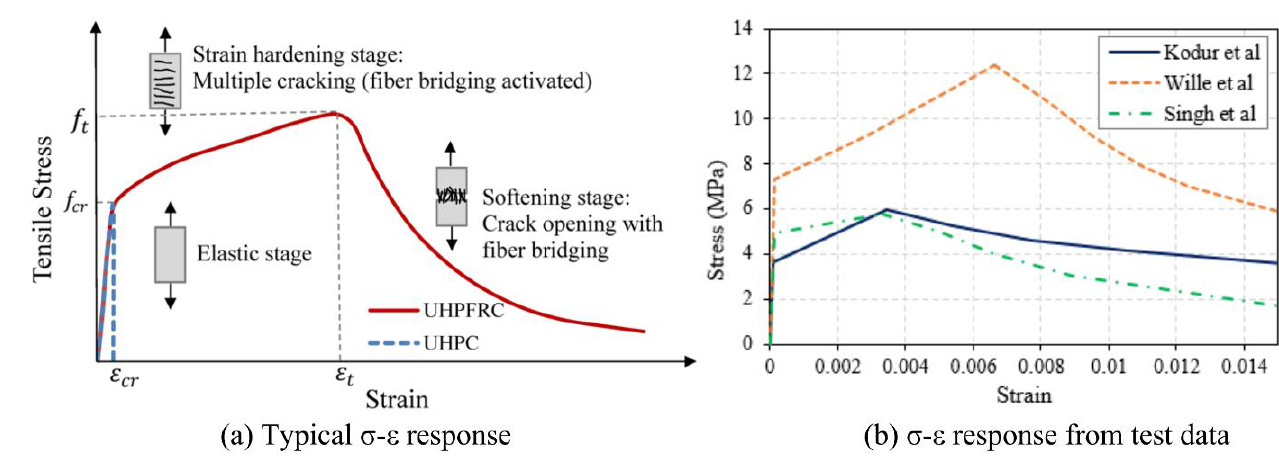
Figure 4. Tensile stress – strain response of UHPFRC, ( a ) typical σ - ε response, ( b ) σ - ε response from test data.